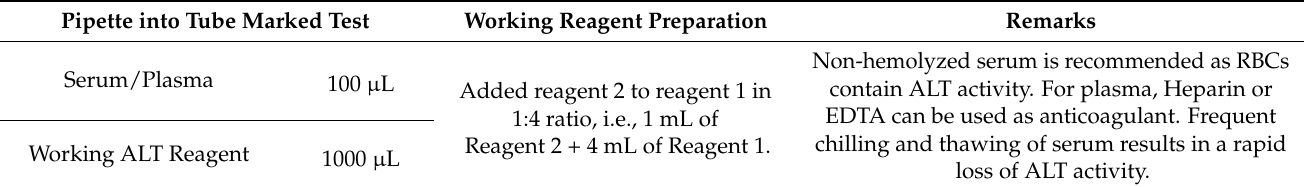
Table 2. Estimation protocol for alanine transaminase (ALT).